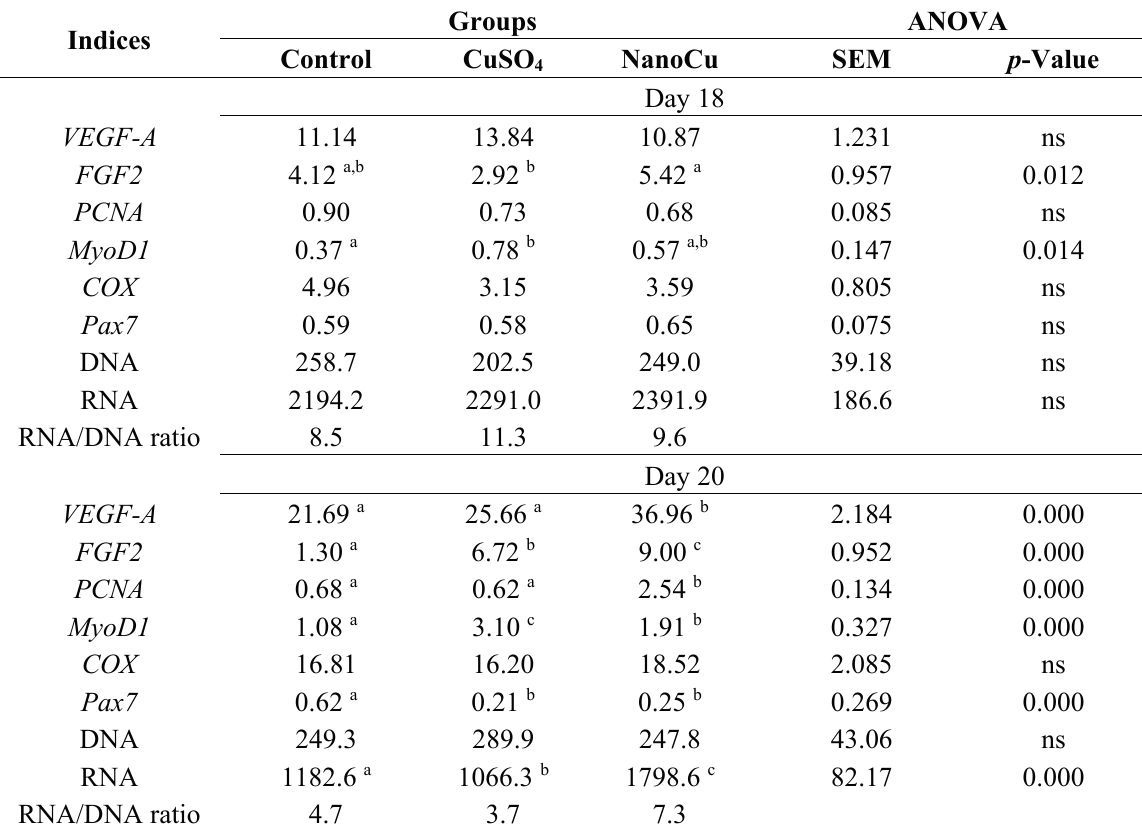
Table 3. The mRNA expression of VEGF-A , FGF2 , PCNA , MyoD1 , PAX7 and COX genes and concentration of DNA and RNA in the samples of pectoral muscles of embryos at day 18 and day 20, after in ovo treatment with CuSO 4 and nanoparticles of Cu